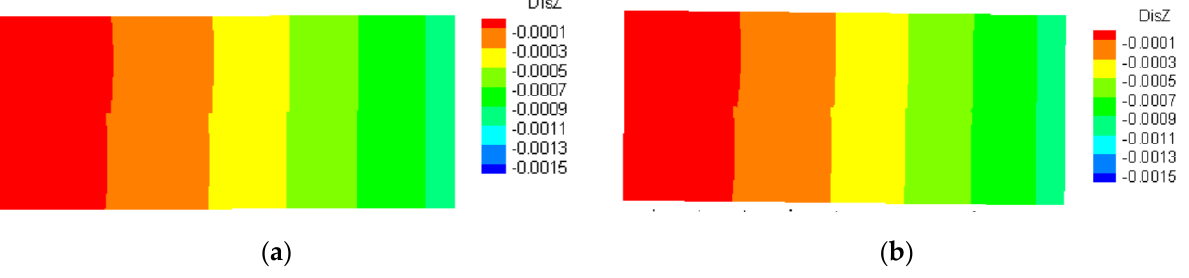
Figure 8. The distribution of displacement in Z-direction. ( a ) SBFEM. ( b ) ANSYS.